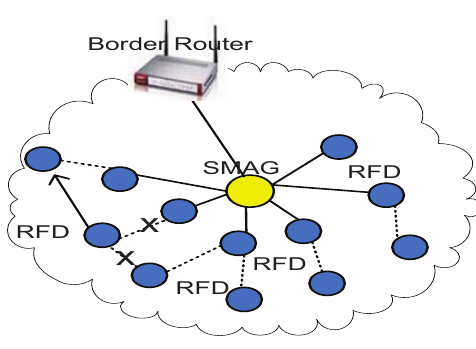
Figure 5. Intra-SMAG Communication.